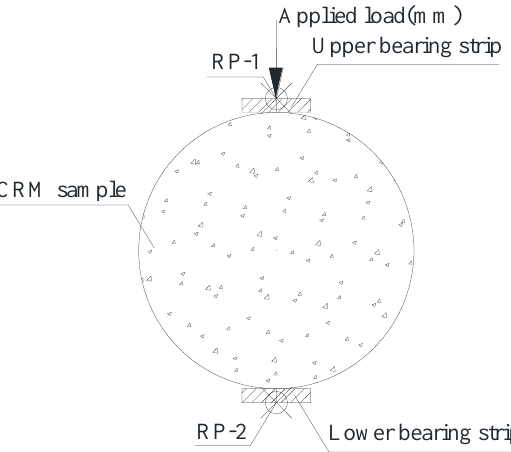
Figure 10. Schematic diagram of CRM specimen for indirect tensile test.